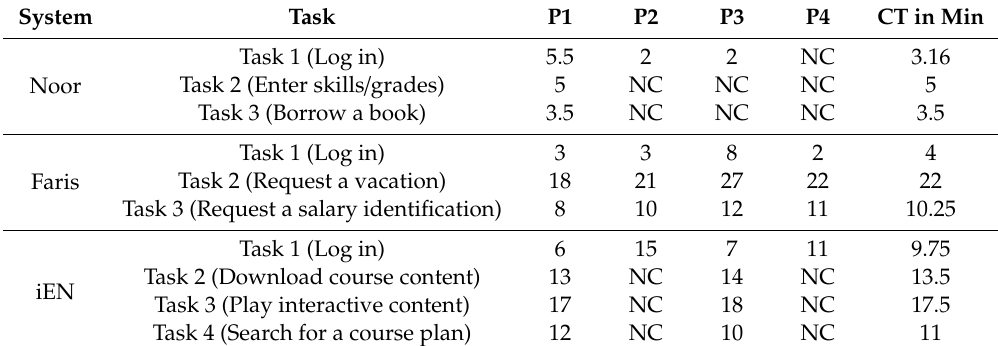
Table 11. Average completion time (CT) per task for each system in